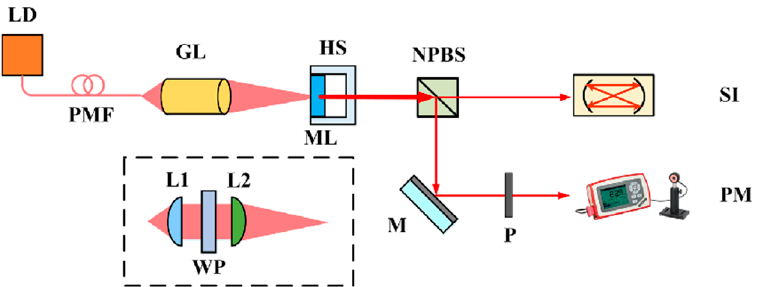
Figure 20. Schematic setup of the dual-frequency microchip laser [29]. LD: laser diode; PMF: polar-